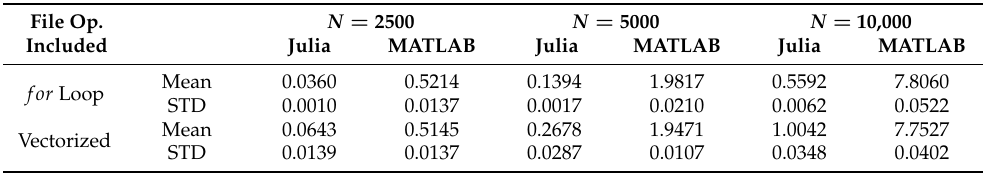
Table 1. Mean execution times and standard deviations of the Burgers’ equation solver written in MATLAB and Julia by including file operations. The mean execution times are given in second. Ten data points are used in the calculation of the mean and the standard